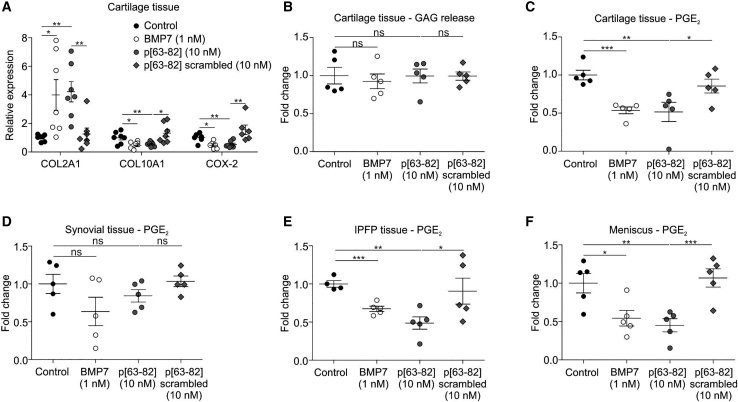
Peptide p[63−82] activity on OA knee joint tissuesHuman OA knee joint tissues were cultured for 24 h in the presence of BMP7, peptide p[63−82], or the scrambled version of peptide p[63−82] and compared to control conditions. (A) Cartilage tissues (n = 7 individual donors) were exposed to shown conditions and analyzed for COL2A1, COL10A1, and COX-2 mRNA expression by quantitative real-time PCR (normalized for 28S rRNA expression and relative to control conditions). (B) GAG release in medium from cartilage tissues (n = 5 individual donors) was determined, and data were calculated relative to the control condition. (C) PGE2 levels in culture supernatant from synovium (n = 5 donors). (D) PGE2 levels in culture supernatant from cartilage tissues from (B) (n = 5 donors). (E) PGE2 levels in culture supernatant from IPFP (n = 5 donors). (F) PGE2 levels in culture supernatant from the meniscus. Synovium, IPFP, and meniscus tissues were from the same 5 donors as the cartilage tissues in (B) and (C). PGE2 levels in conditions were calculated relative to controls for each donor. In graphs, error bars represent mean ± SEM; data are presented relative to the control condition for each time point. Statistical differences (unpaired two-tailed Student’s t test) were calculated to control condition: ∗p < 0.05, ∗∗p < 0.01, and ∗∗∗p < 0.001.